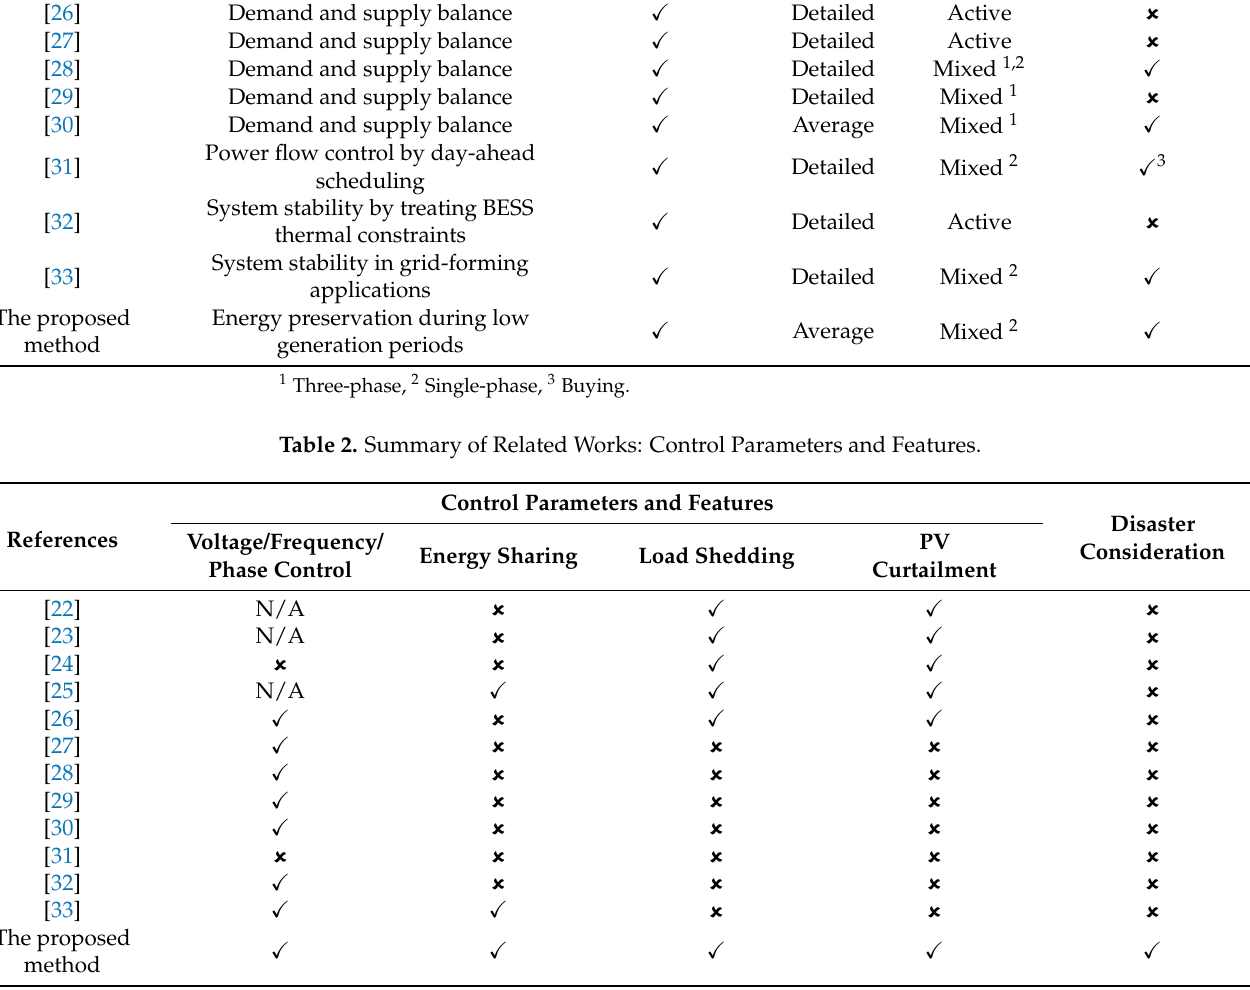
Table 1. Summary of Related Works: Objectives and model.